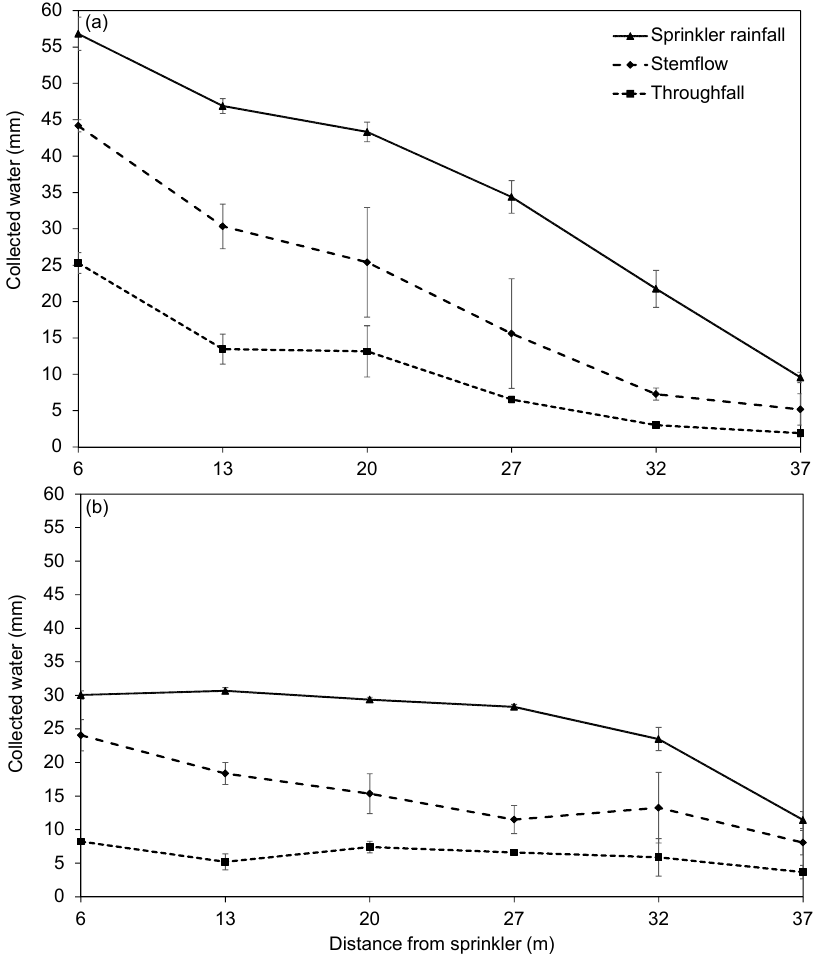
Figure 6. Spatial variability of sprinkler rainfall and its partitioning between stemflow and throughfall ( a ) during the first event (4 July) and ( b ) the second event (2 August). Error bars indicate standard errors.